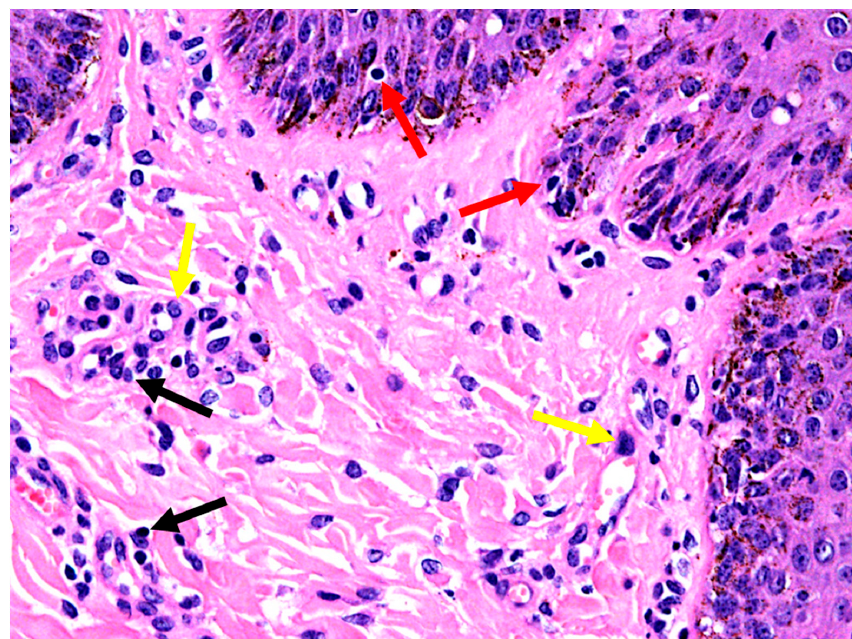
Figure 5. Skin histopathology from a horse with severe dermatitis; mild lymphocytic, hyperplastic dermatitis (H.E. 4× objective). Black arrow indicates hyperplasia (acanthosis) of the epidermis. Red arrows indicate mildly increased surface keratin.